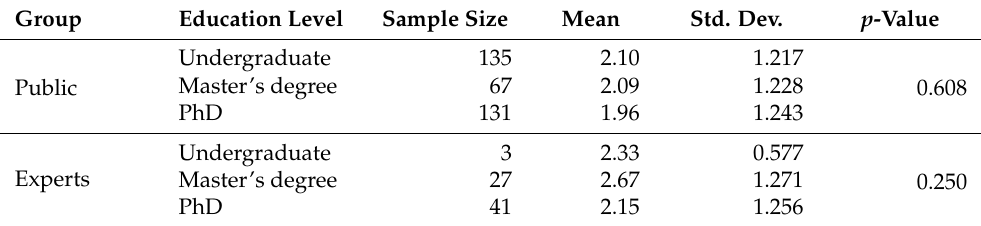
Table 9. Willingness to install a wind turbine in one’s own garden, grouped by level of education. Group